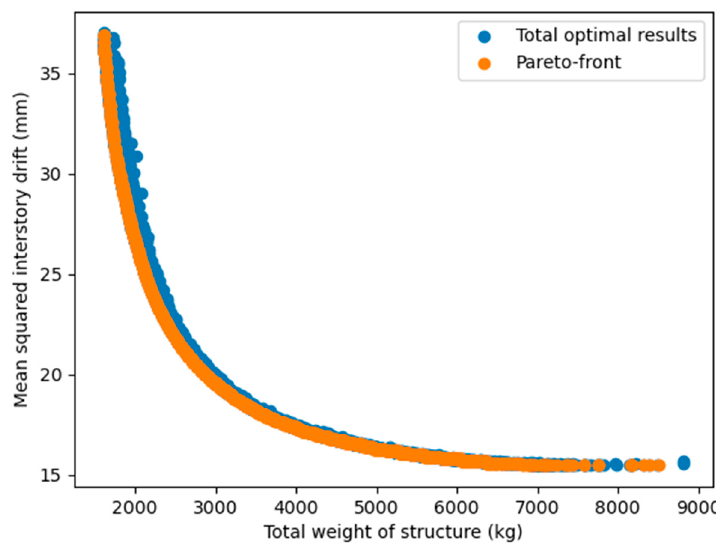
Figure 9. The approximate Pareto-front of the 72-bar truss.